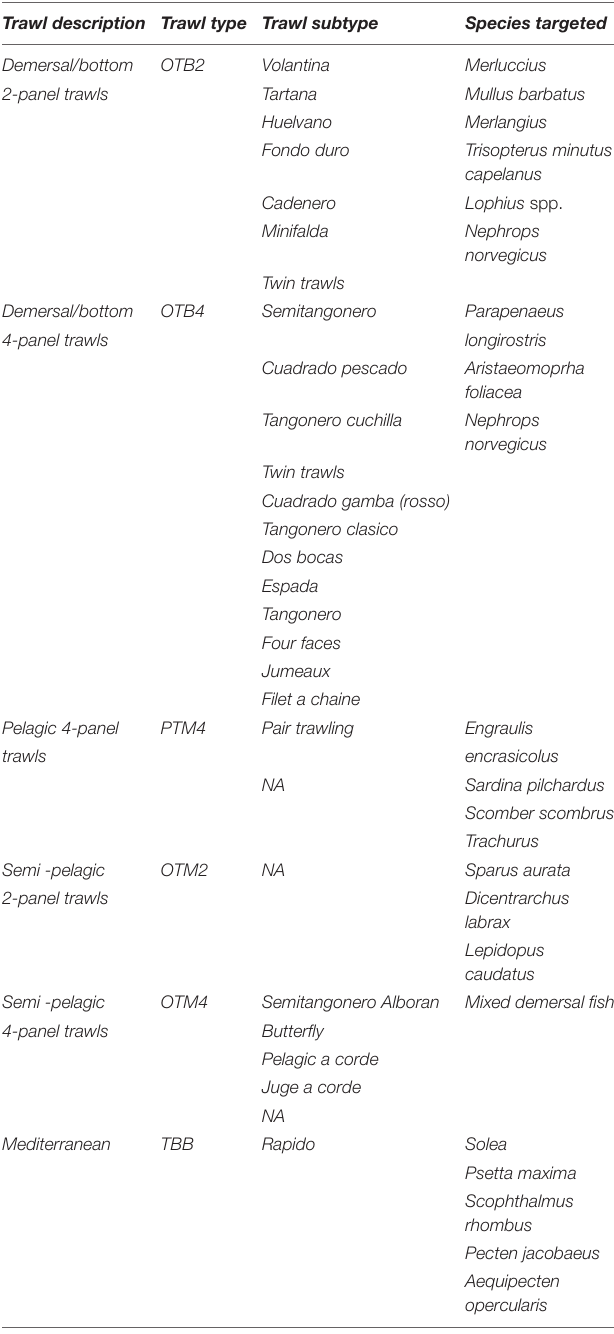
TABLE 1 | Summary table of the observed gear types and subtypes followed by an indication of the major species targeted. Trawl description Trawl type Trawl